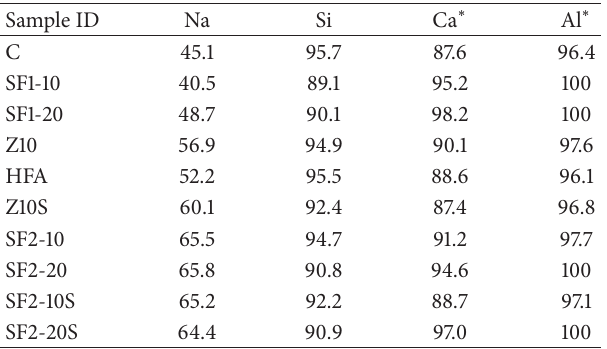
Table 3: Reactivity calculated from insoluble Si or Na element content of powder sodium silicate in distilled water (%).